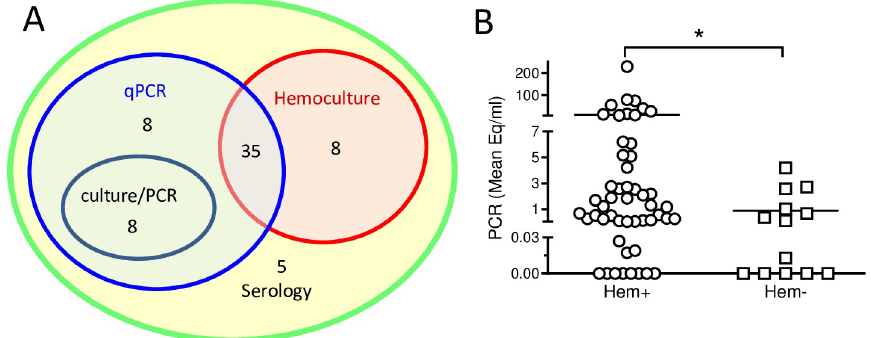
Fig 1. Serial qPCR and hemoculture confirmed T . cruzi infection in 92% of seropositive macaques. (A) Study group. Peripheral blood samples from 64 macaques positive for T . cruzi infection by conventional serology were screened by serial qPCR and hemoculture performed as described in Materials and Methods. Serologically positive macaques were confirmed by blood qPCR (qPCR), visible parasites in hemocultures (Hemoculture) and by qualitative PCR in hemocultures without visible parasites (culture/PCR). (B) Parasite load in blood determined by serial qPCR versus presence or absence of parasite growth in macaque hemocultures. Hemocultures designated positive (Hem+) showed parasite growth or qualitative PCR+ in the culture. Blood samples were analyzed by qPCR at up to three time points, and the mean value of T . cruzi equivalents per ml in all the samples for each individual macaque was calculated. Each symbol represents an individual macaque (n = 64). � indicates P < 0.05 as determined by Mann Whitney